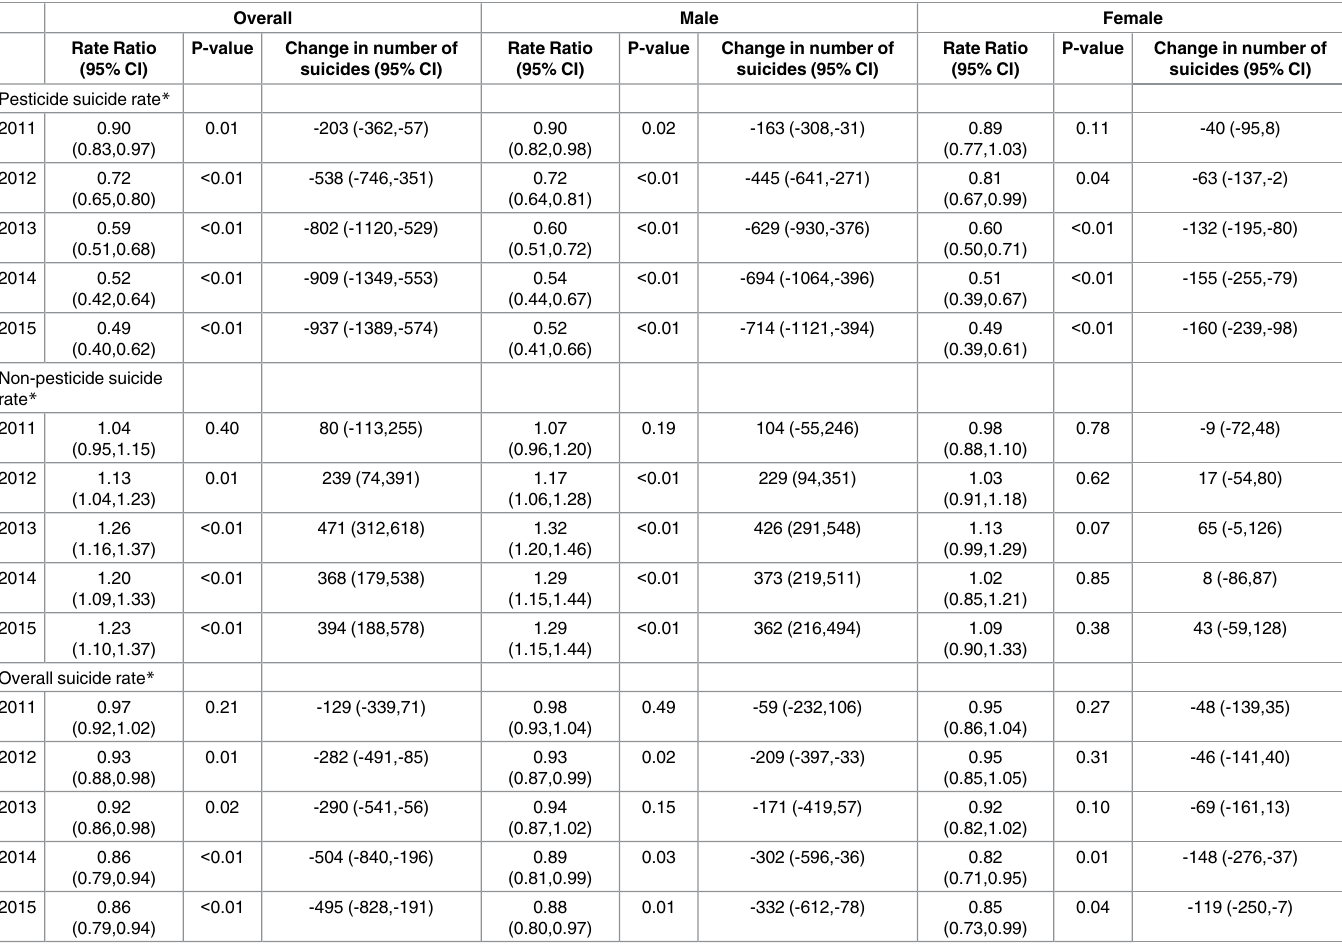
Table 1. Rate ratios and change in the number of suicides in years 2011–2015 after the phased bans of paraquat, dimethoate and fenthion relative to those expected based on trend 2001–10.